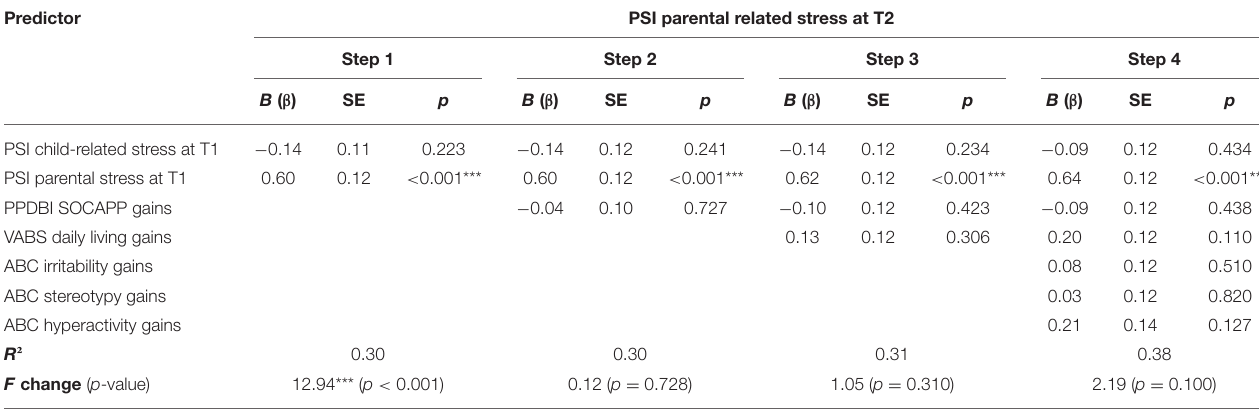
TABLE 5 | Hierarchical multiple regression analysis (pooled) predicting PSI parental related stress at T2.